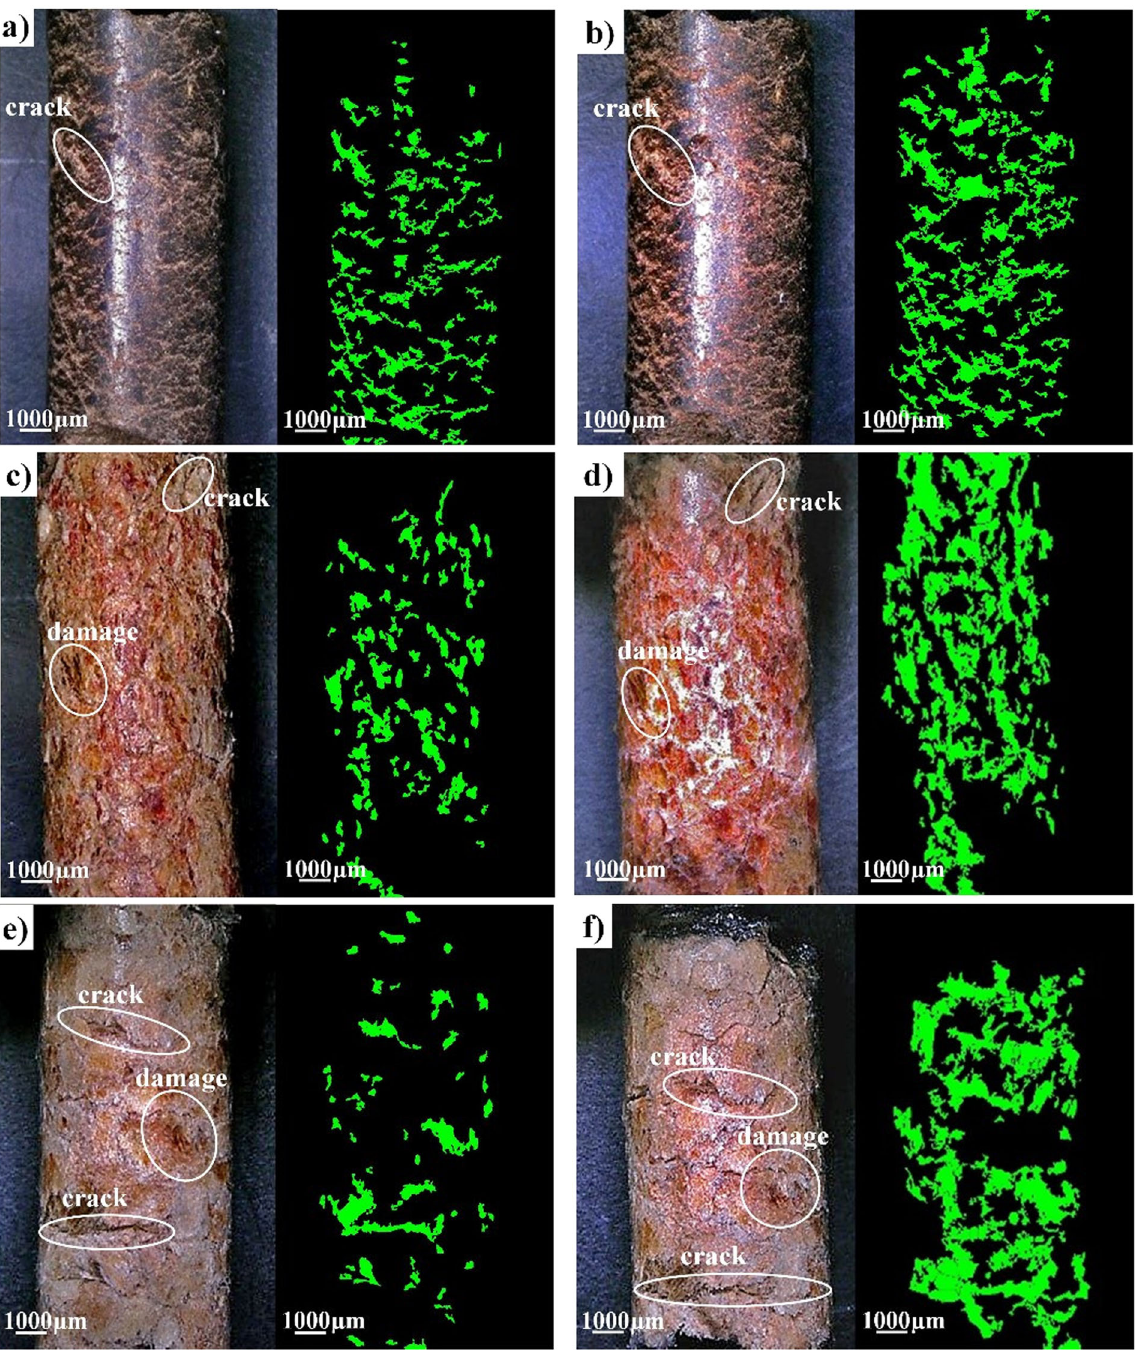
Fig. 2 Digital images and corresponded determined damage area of pellets. a , b Torre fi ed pellet (tor_sample3) before storage ( a ) and after 1 month of storage ( b ). c , d Wood pellet type I (wp1_sample3) before storage ( c ) and after 1 month of storage ( d ). e , f Wood pellet type II (wp2_sample3) before storage ( e ) and after 1 month of storage ( f ). Surface damage is highlighted in